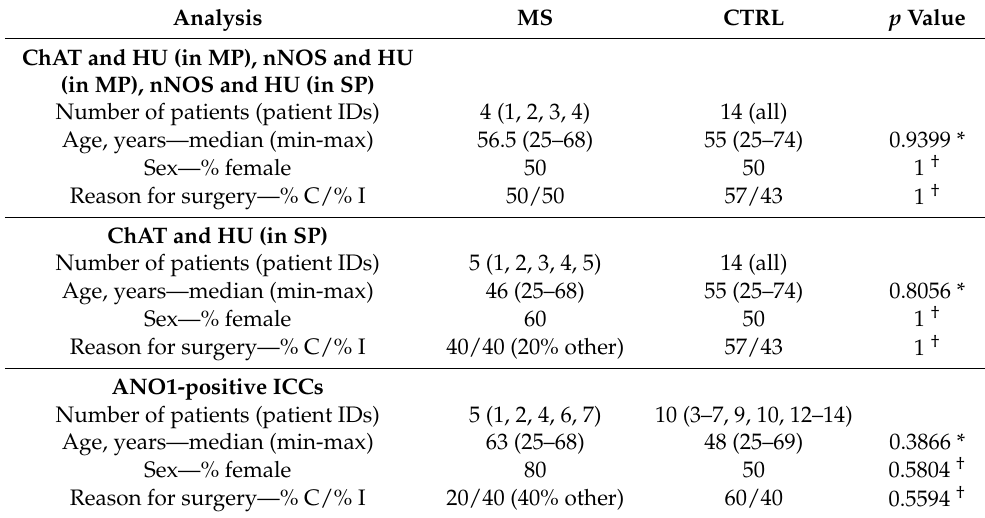
Table 3. Overview of the MS and Non-MS CTRL Patient